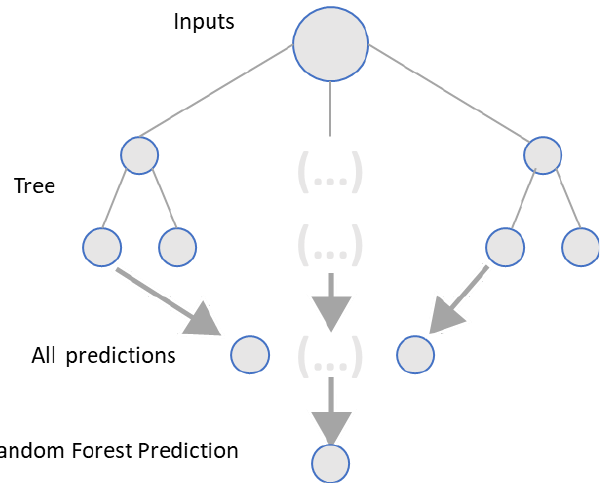
Figure 2. Diagram of a random forest regressor (RFR).